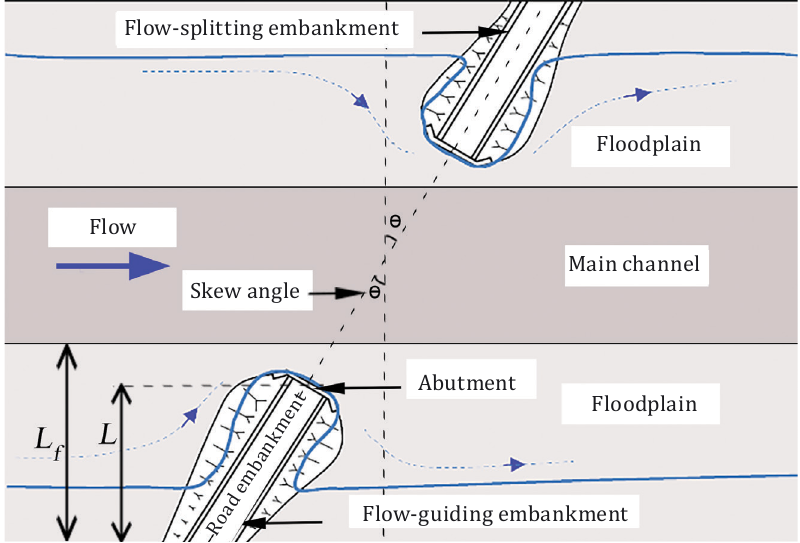
Flow-splitting embankment Figure 1. Illustration of the plan of a skewed bridge with θ angle in a compound channel